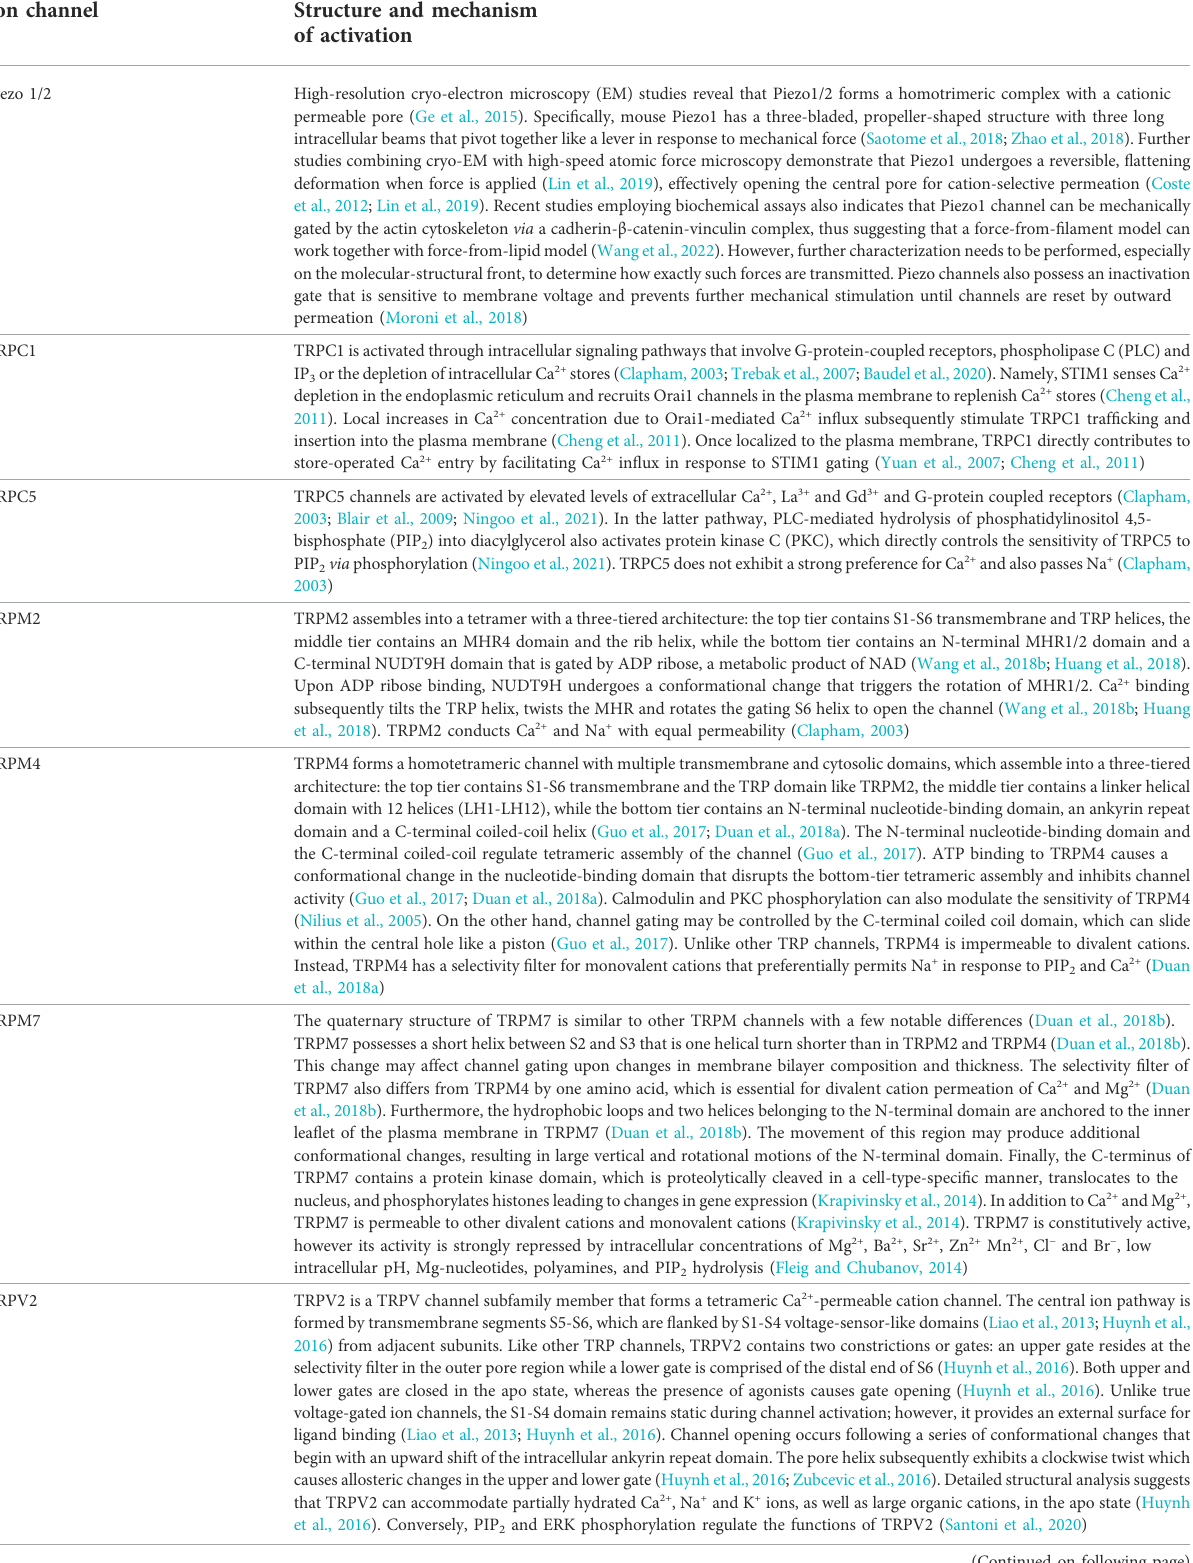
TABLE 2 Mechanosensitive ion channels and their gating